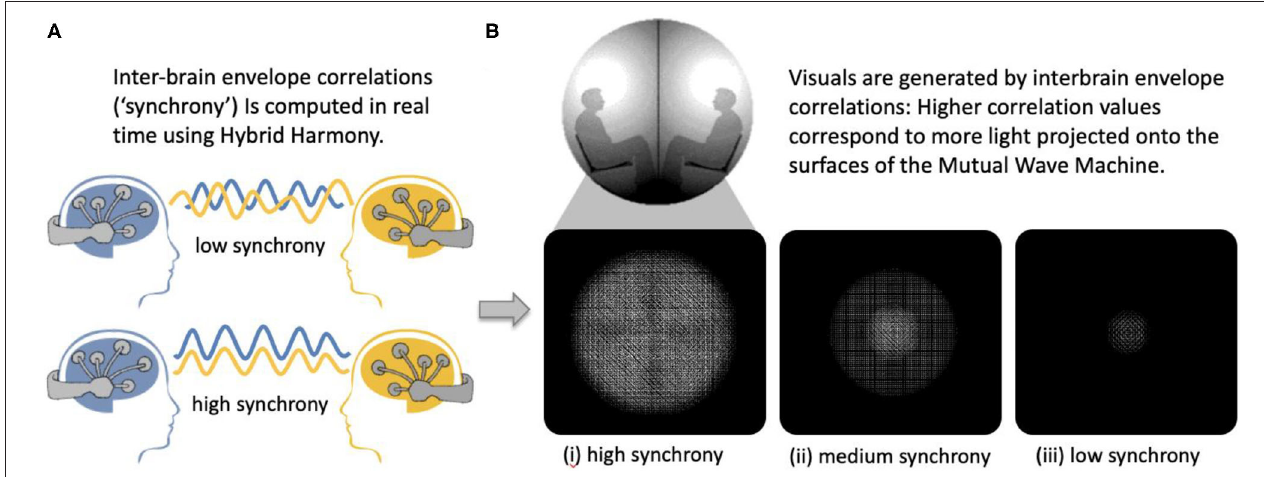
FIGURE 7 | The Mutual Wave Machine using inter-brain envelope correlations with Hybrid Harmony. (A) Inter-brain correlations between two participants wearing wireless EEG headsets were computed in real time. (B) Higher inter-brain correlation values correspond to more light projected on each of the surfaces, with the focus point behind each participant’s